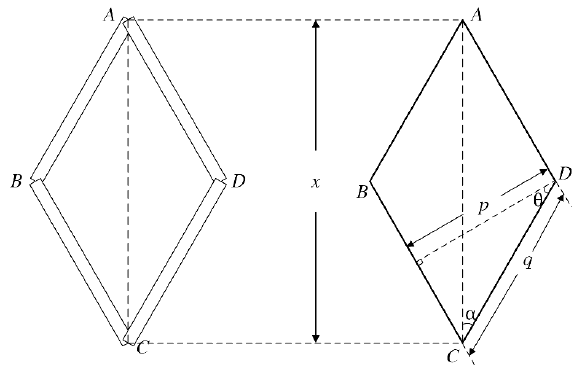
Figure 2. Diamond trellis.